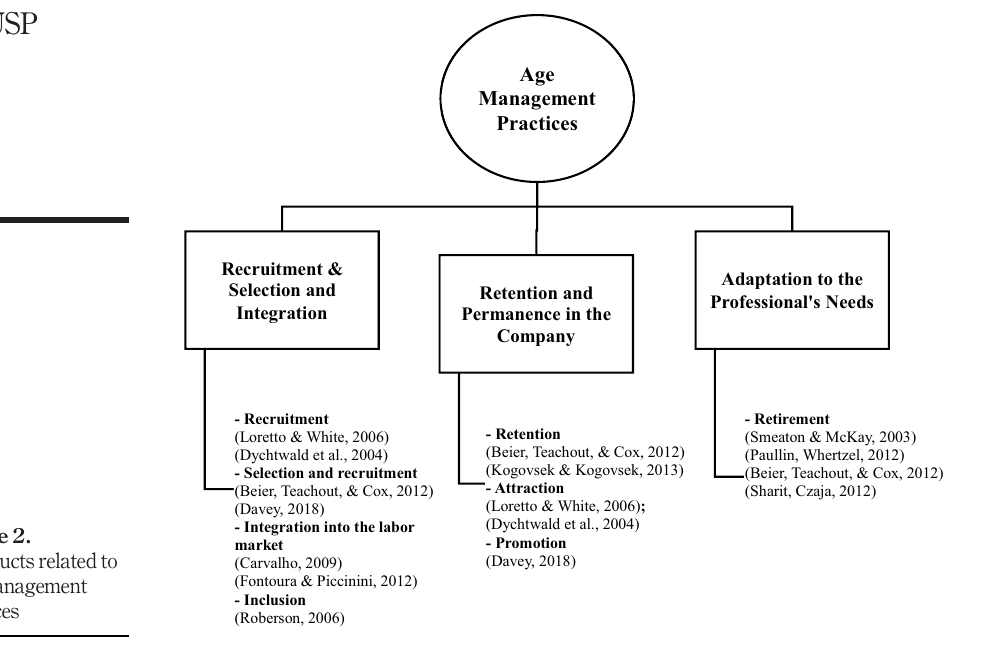
Figure 2. Constructs related